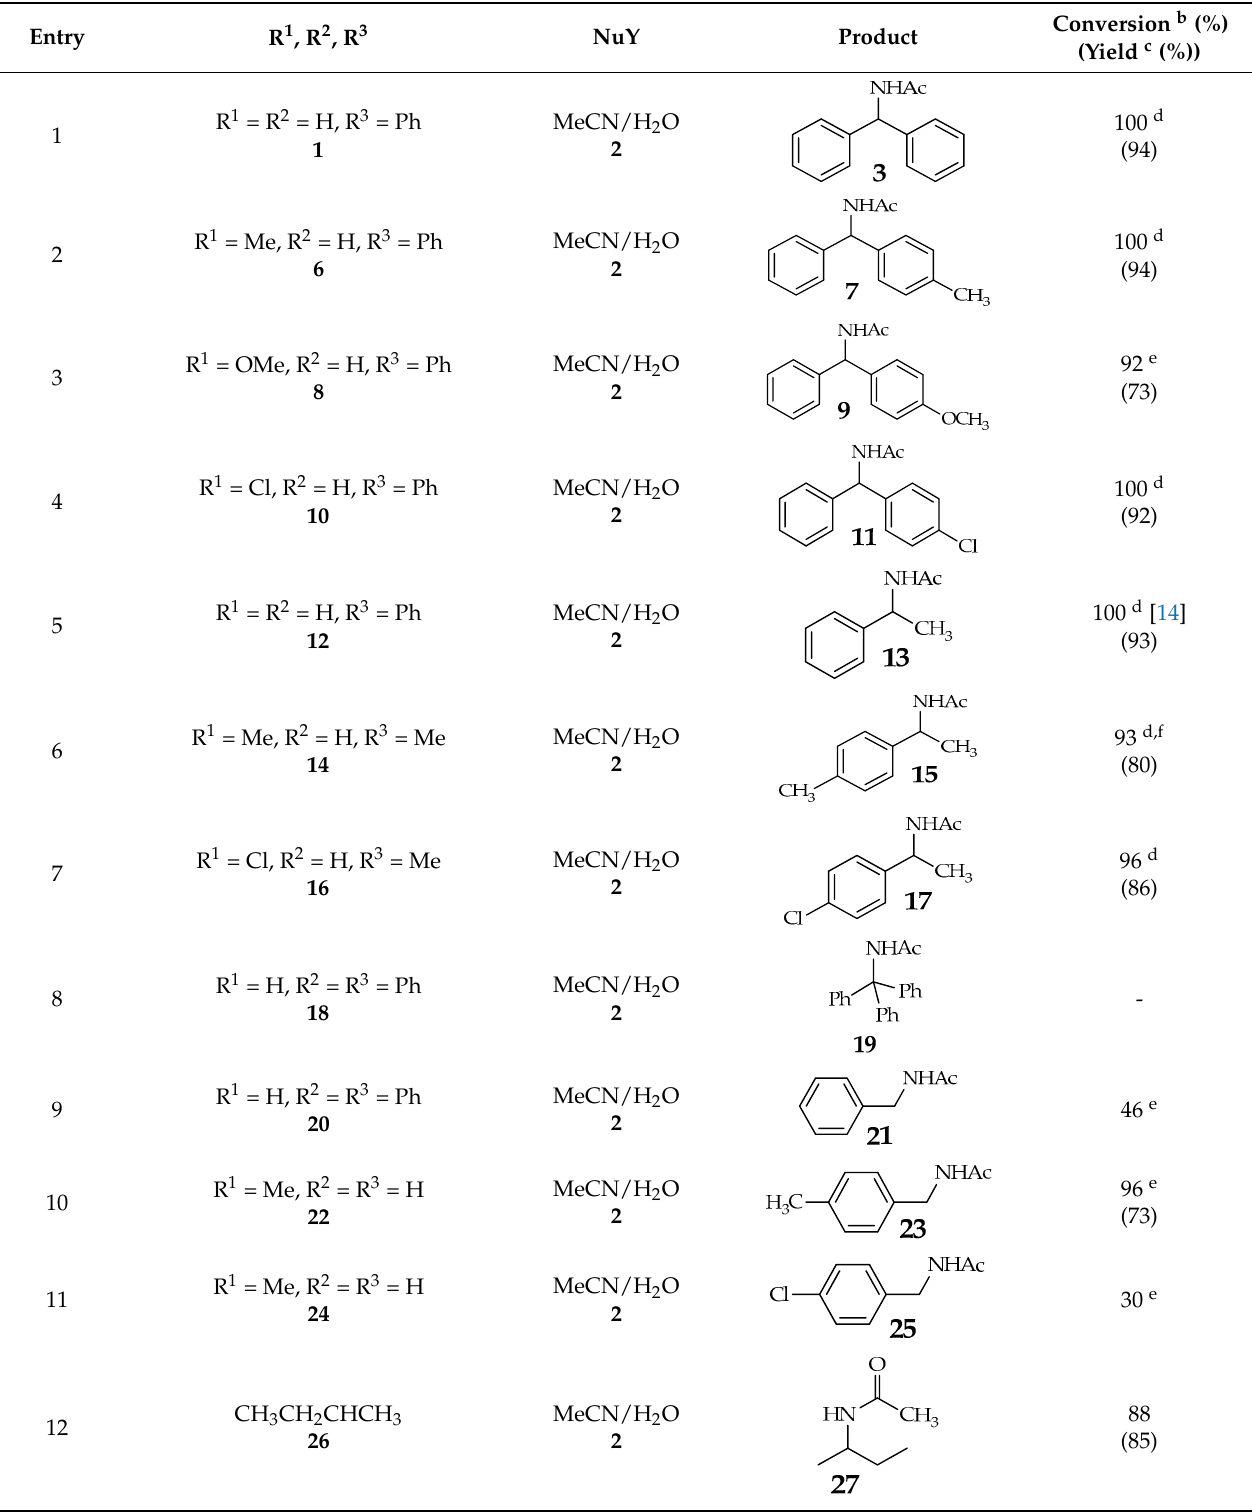
Table 2. Nucleophilic substitution of alcohols using NIS as a precatalyst a .